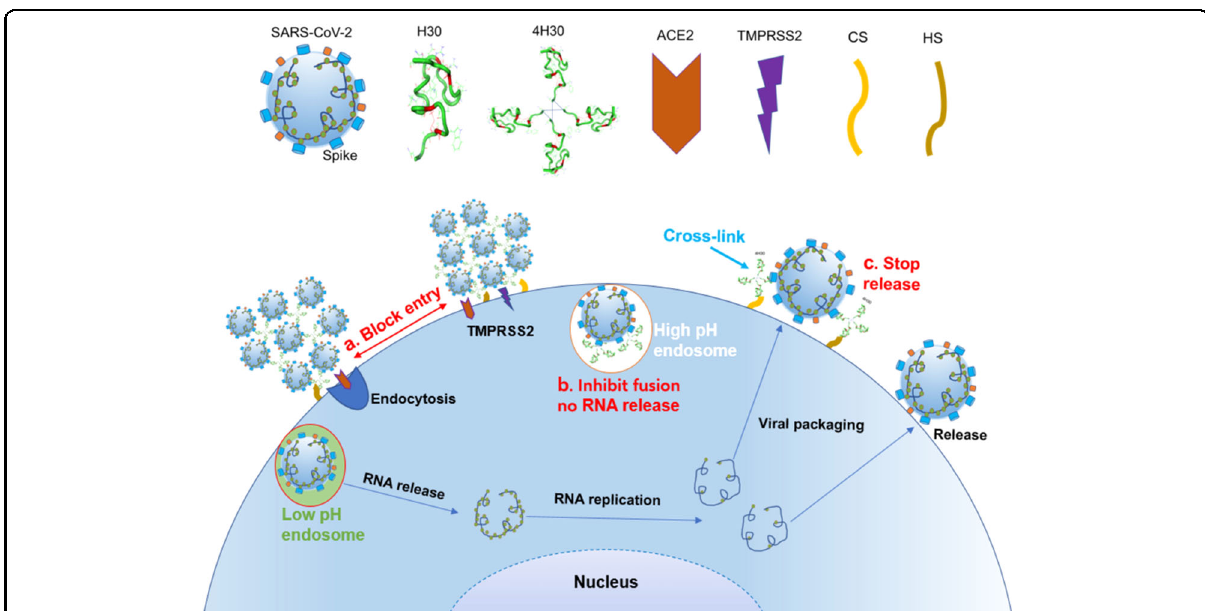
Fig. 6 Schematic model of 4H30 inhibiting SARS-CoV-2 infection by triple mechanisms. a 4H30 can cross-link SARS-CoV-2 to form big virus clusters, which can block the two entry pathways in VeroE6 (mediated by endocytosis) and Calu-3 cells (mediated by TMPRSS2). b SARS-CoV-2, which is not cross-linked by 4H30 and enters cells by endocytosis, can be stopped in endosomes due to the inhibition of 4H30 on endosomal acidi fi cation, which blocks virus envelope fusion with the endosomal membrane. c 4H30 can stop viral release by cross-linking virus with cell-surface HS/CS. Collectively, 4H30 can inhibit viral entry, fusion, and release of